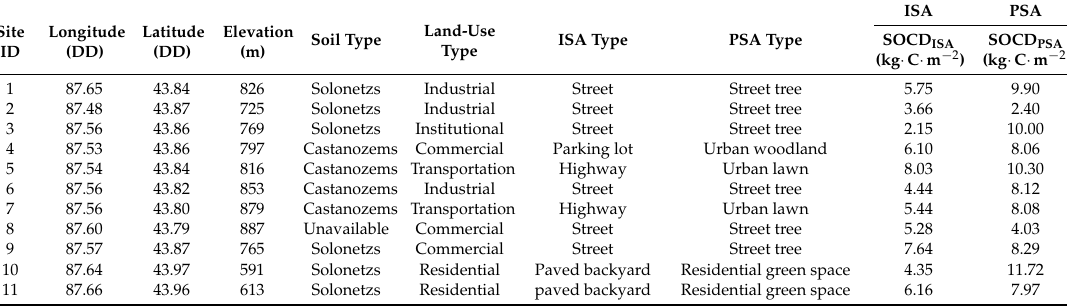
Abbreviations: ISA—impervious surface area, PSA—pervious surface area.